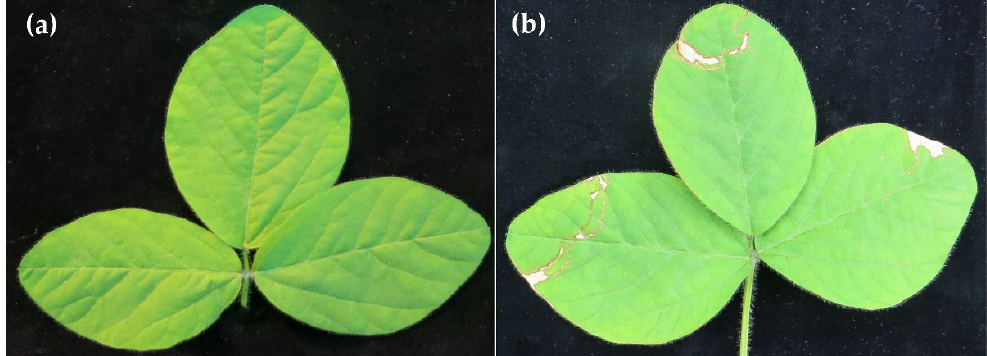
Figure 5. Soybean trifoliates treated with 6PAP ( a ) or Osiris ® ( b ) and incubated undetached for 14 d under greenhouse conditions.